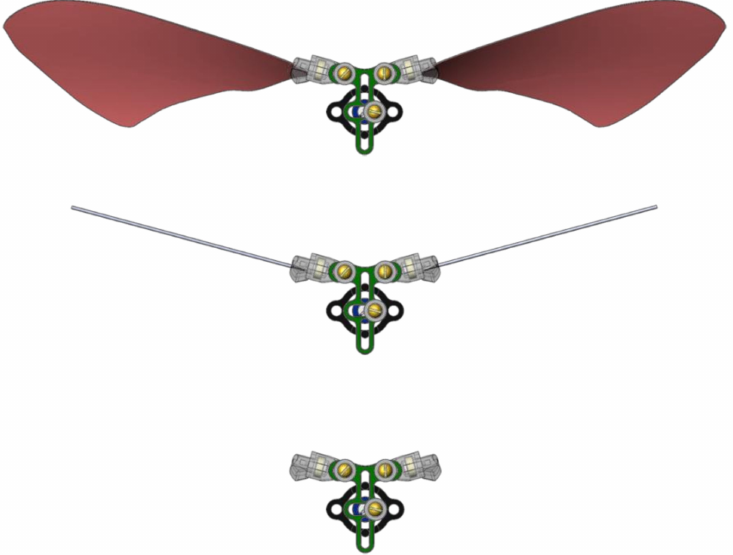
Figure 6. ( top ) FWM 2.1 with artificial forewings attached. ( middle ) FWM 2.1 with metal rods attached that are equivalent to the mass of the forewings but have minimal air resistance. ( bottom ) FWM 2.1 with nothing